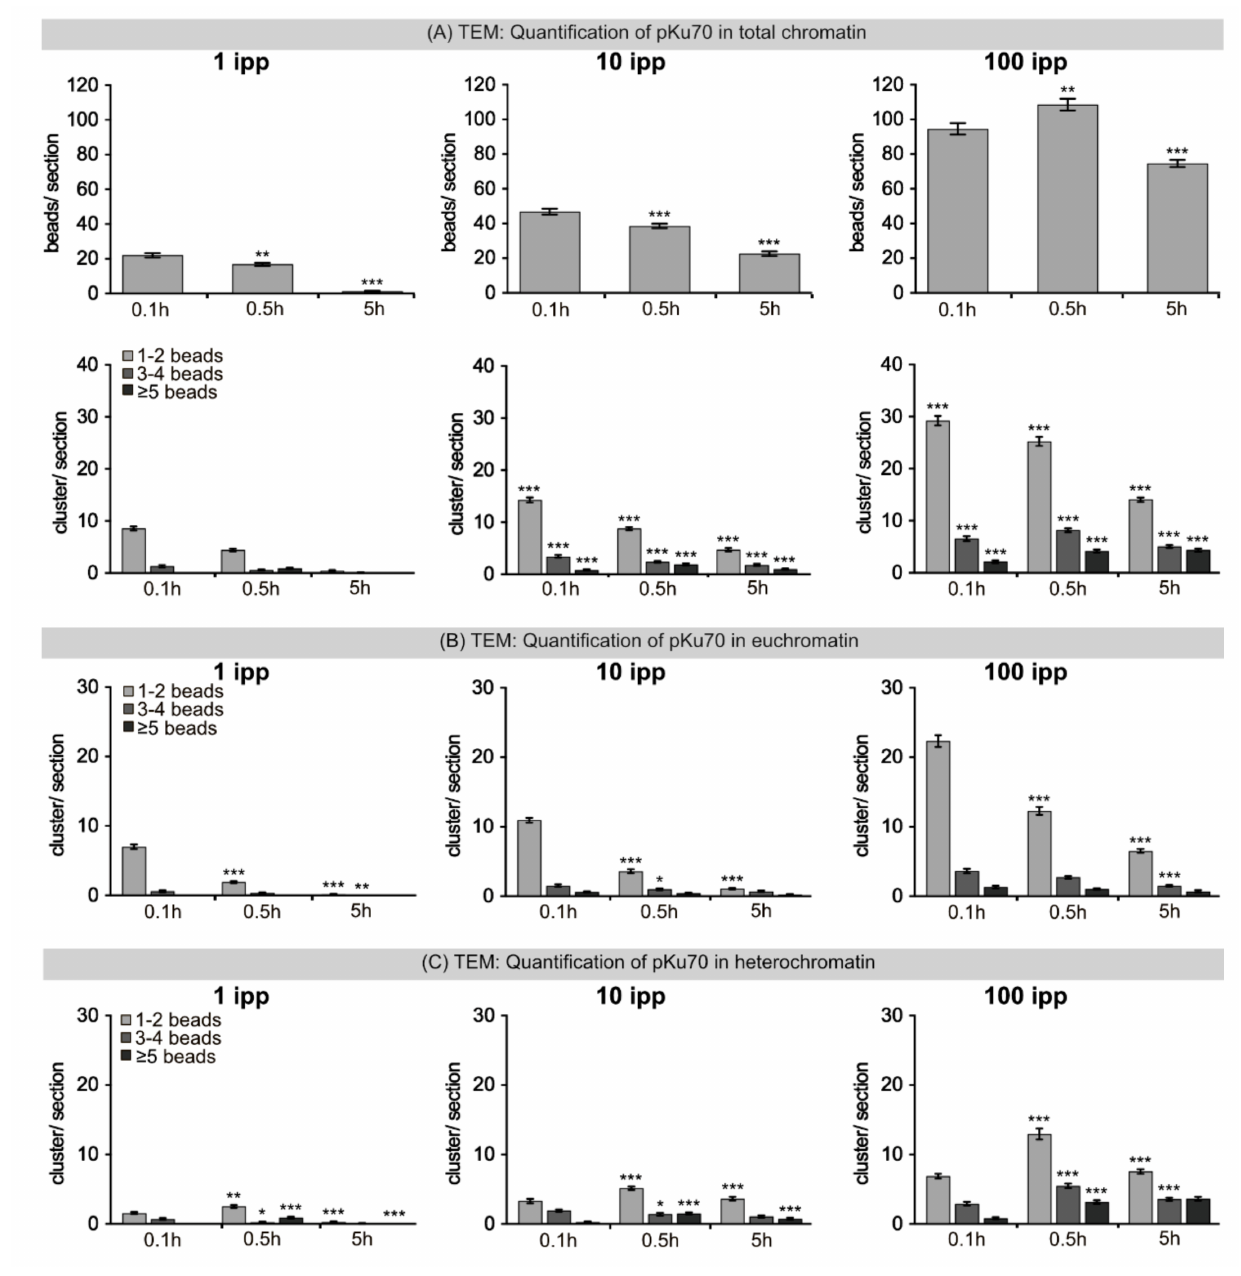
Figure 5. Quantification of pKu70 beads and clusters after microbeam IR with carbon ions. ( A ) For pKu70 the number of beads and clusters (with 1–2, 3–4 and ≥ 5 beads per cluster, reflecting lesion complexity) were quantified in the total chro- matin of ≥ 25 nuclear sections after focused microbeam IR with 1, 10 and 100 ipp. Statistical significances for beads/section based on comparison to previous timepoint. Statistical significance for cluster/section based on comparison to equivalent cluster size and timepoint of lower dose (i.e., 10 ipp vs. 1 ipp, 100 ipp vs. 10 ipp). ( B ) For pKu70 the number of clusters (with 1–2, 3–4 and ≥ 5 beads per cluster) were shown in euchromatin after microbeam IR with 1, 10 and 100 ipp. Statistical significances based on comparison of equivalent cluster size and dose to previous timepoint. ( C ) For pKu70 the number of clusters (with 1–2, 3–4 and ≥ 5 beads per cluster) were shown in heterochromatin after microbeam IR with 1, 10 and 100 ipp. Statistical significances based on comparison of equivalent cluster size and dose to previous timepoint. Data are presented as mean of 3 technical replicates ± SEM. Significant statistical difference * ( p <0.05), ** ( p < 0.01), *** ( p <